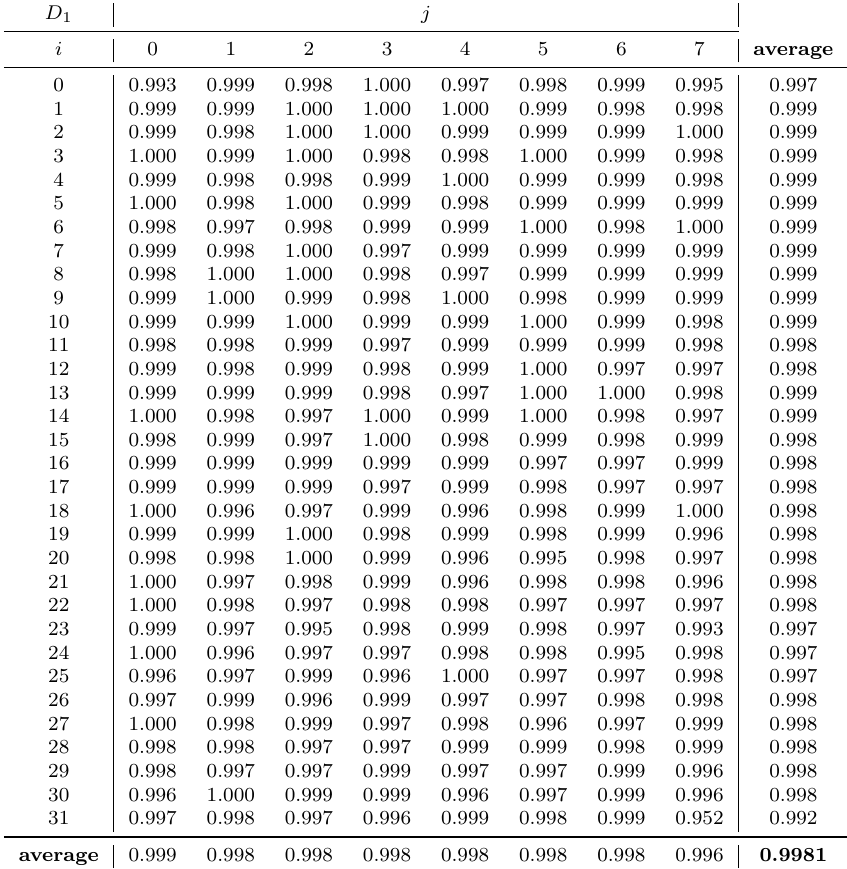
Table 18: Empirical probability to recover the message bit m [8 i + j ] from a single trace using both points. Average results for 1K traces from device D 1 (profiling). D